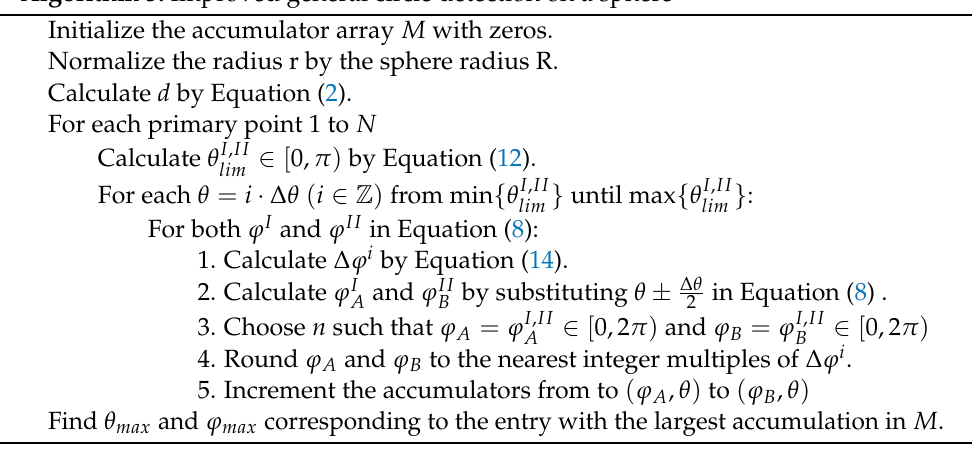
Algorithm 3: Improved general circle detection on a sphere